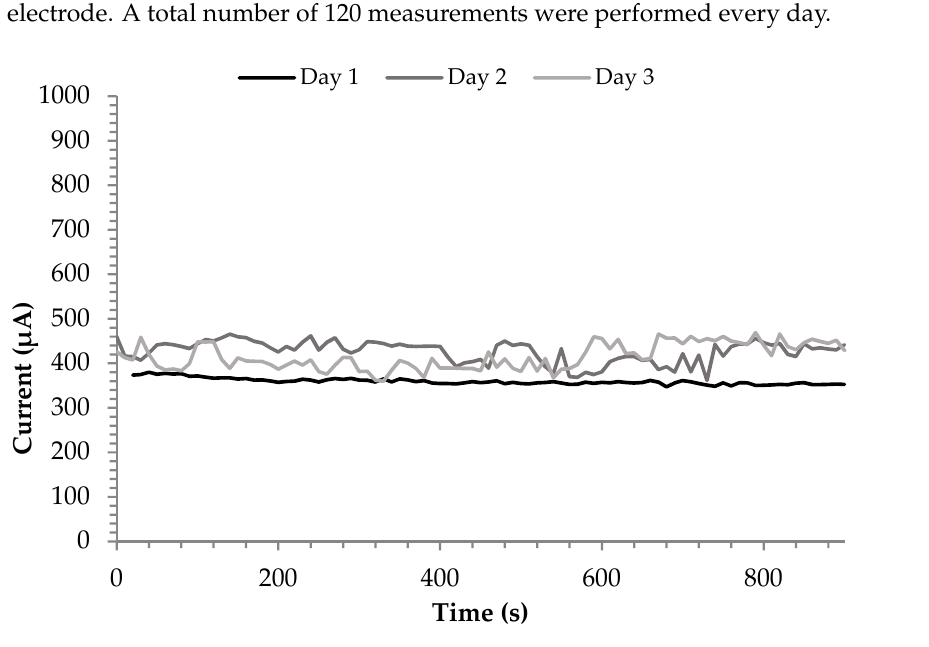
Figure 10. Stability of copper oxide electrode. Pulsed amperometric detection (+0.55V) of 4 mM glucose in 0.1 M NaOH during 1200 measurements each 10 s.